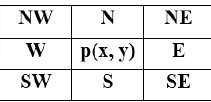
A simple fuzzy differential is obtained by computing the difference between central pixel p ( x , y ) and its neighbor pixels in the direction. The differential value is represented as d D ( x , y ). The membership